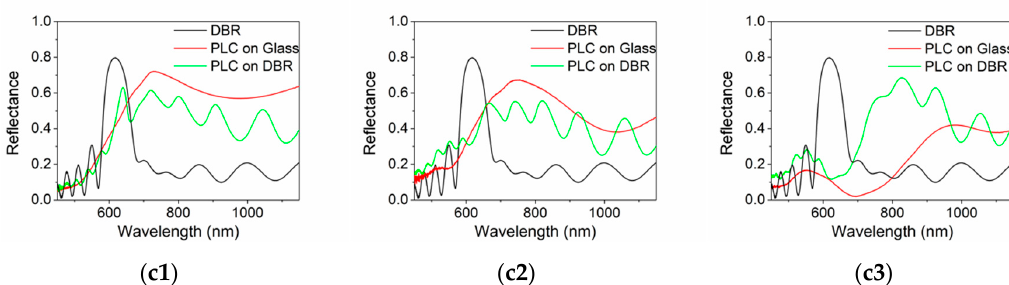
Figure 4. ( a ) SEM images of the hybrid structure for the 1, 2 and 3 polymer layers, respectively. ( b ) Detail of the gold nanocavities for the 1, 2 and 3 polymer layers, respectively. ( c ) Reflectance spectrum of the DBR (black line), of the standard PLC on glass (red line) and of the hybrid structure (green line). As in Figure 3, the numbers 1, 2 and 3 refer to the thickness of the ppAA (50 nm, 100 nm and 150 nm, respectively).